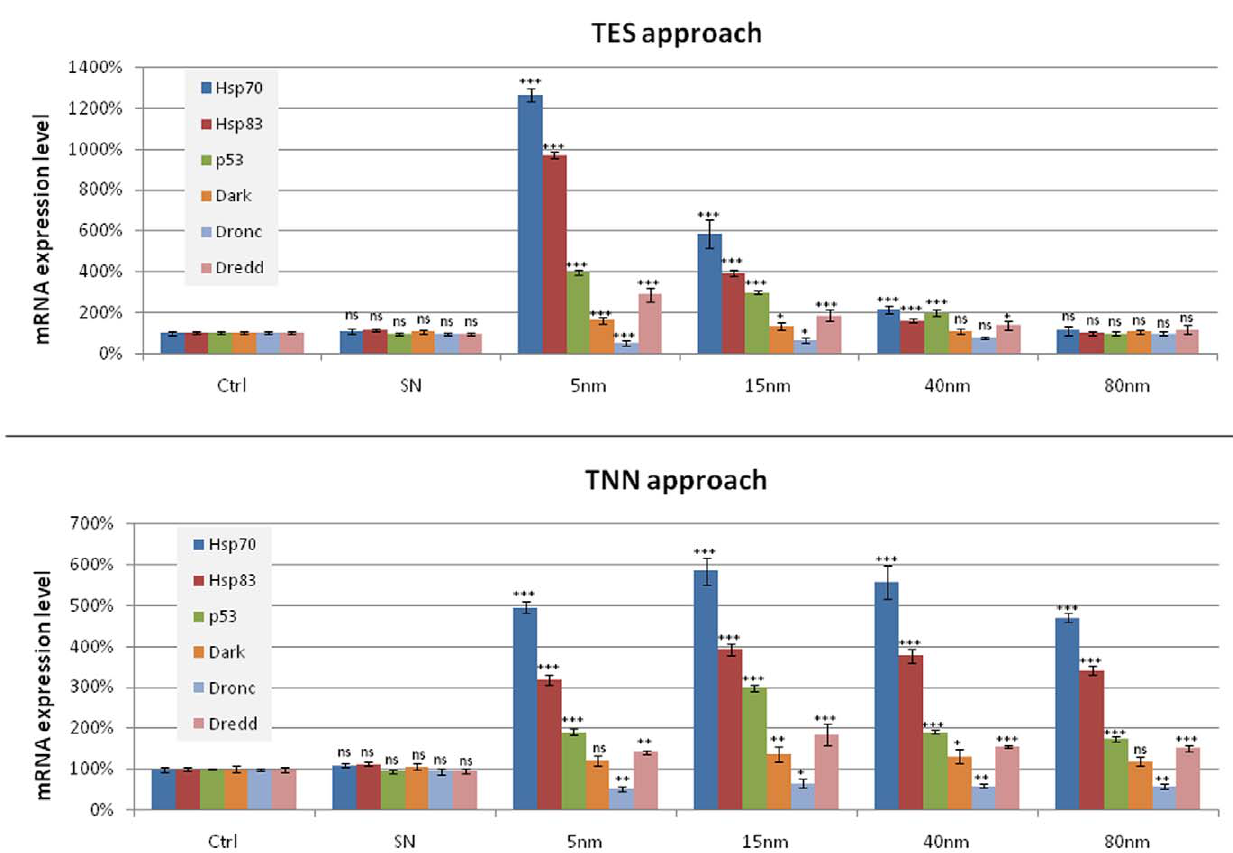
Figure 5. mRNA expression level analyzed by RT-qPCR of Drosophila treated with TES (top) and TNN (bottom) approaches. All data relative to RT-qPCR experiments were analyzed by statistical software to evaluate the significant difference with respect to the control (ns = non significant, i.e. p-value . 0.05; *p-value , 0.05; **p-value , 0.01 ***p-value , 0.001).